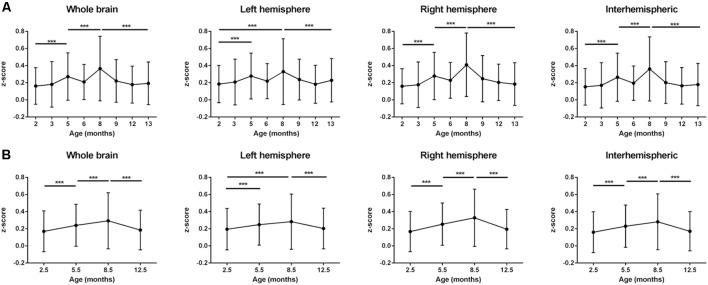
Averaged z-score values of left and right intra-hemispheric, inter-hemispheric and whole-brain connectivities. (A)
z-score values, analyzed at the eight experimental time points (2, 3, 5, 6, 8, 9, 12 and 13 months). The power of correlation increases up to month 8 and then decreases again until month 13 in a fluctuating way. (B)
z-scores of equally spaced pairs of time points (averaged z-scores for 2–3, 5–6, 8–9, 12–13 months, see “Materials and Methods” section). Smoothed temporal trends show an inverse-U shape curve peaking at month 8.5. Error bars indicate SD. ***p < 0.001.